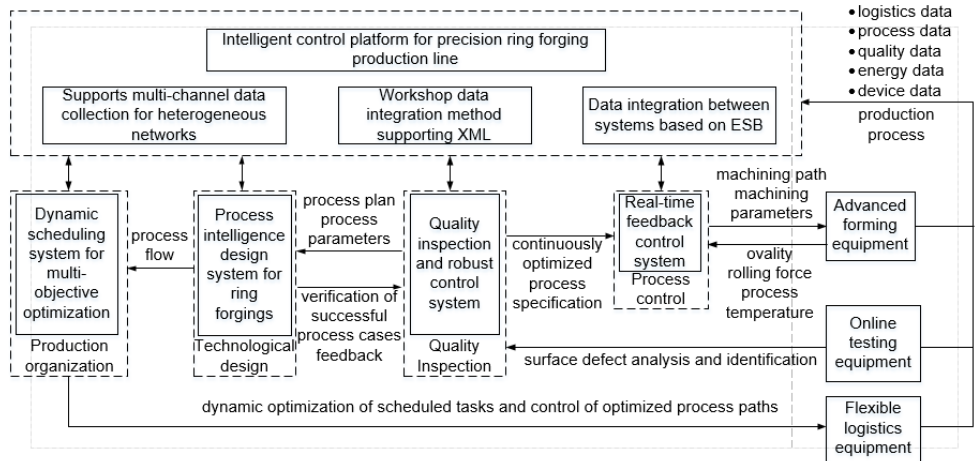
Figure 13. Architecture of the multi-level closed-loop intelligent management and control system